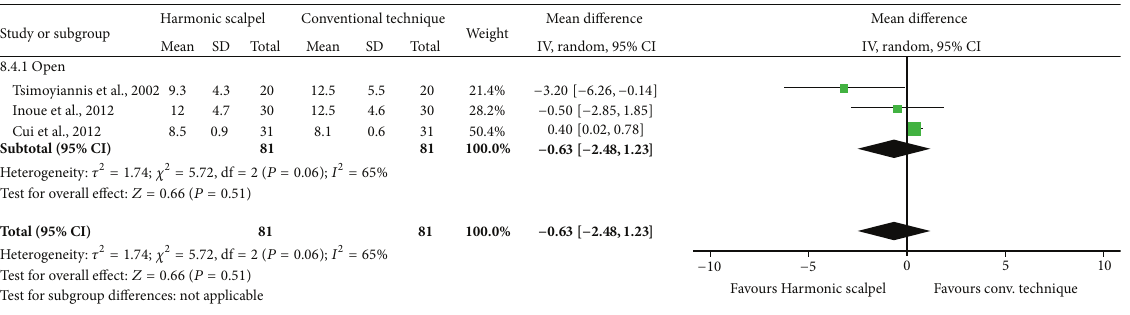
Figure 6: Forest plot of meta-analysis results for length of hospital stay